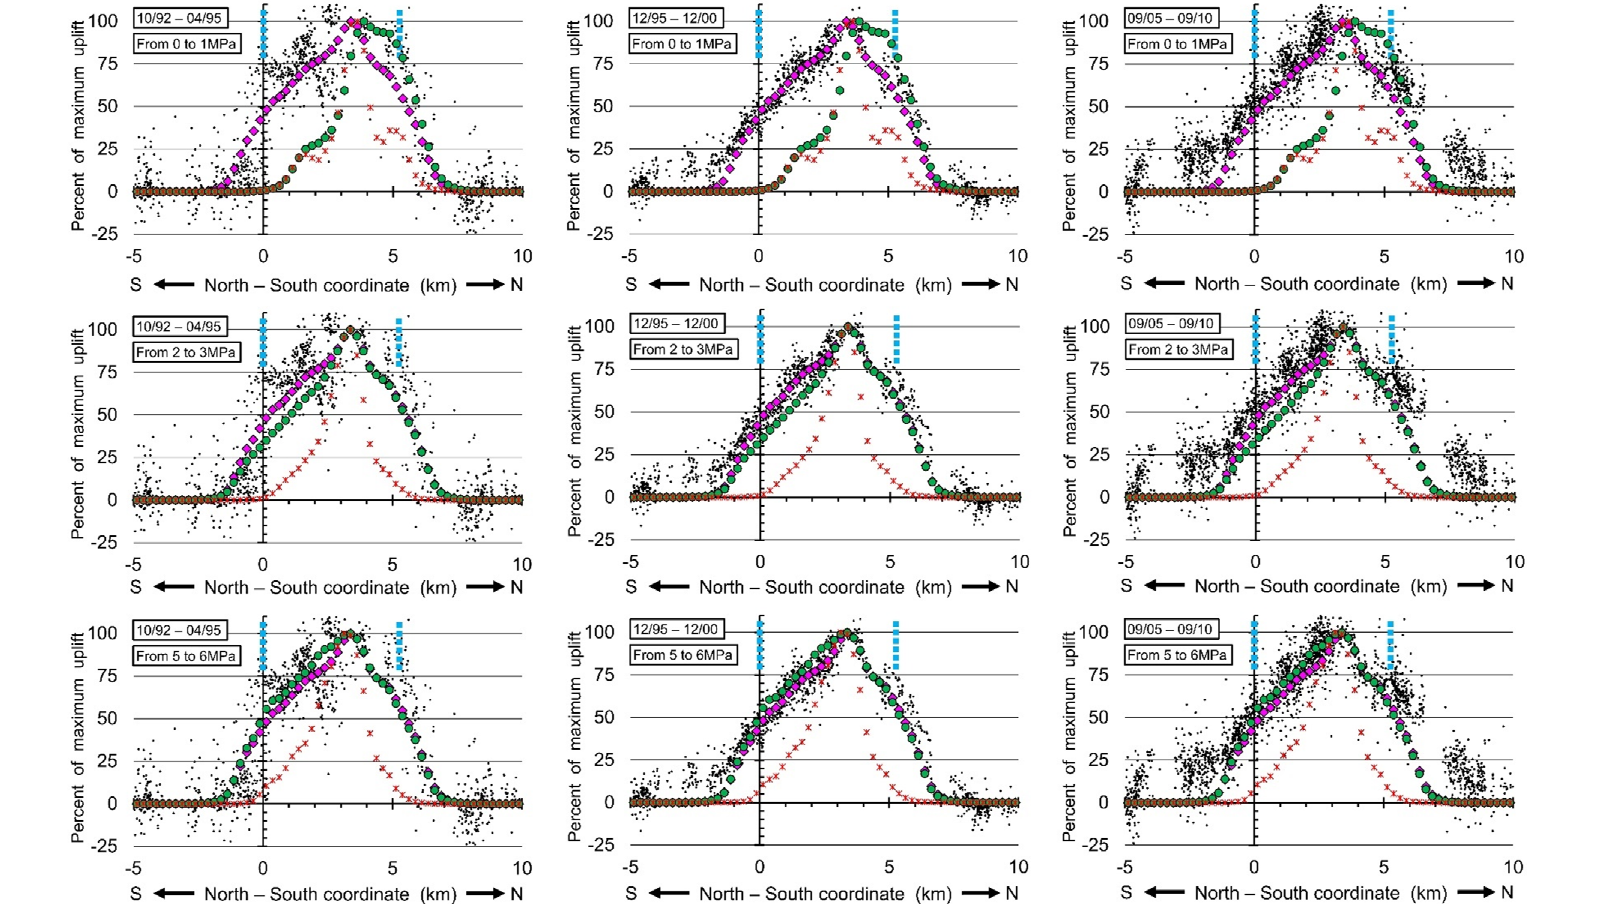
Figure 4. Comparison between InSAR data for three different time periods (black dots), estimations based on framework and property values presented in [17] (purple diamonds) and estimations for open reservoir scenario (green circles for contribution by goaf volume and strata surrounding mining activities, and red crosses for contribution by goaf volumes only). The three time periods are from October 1992 through April 1995 (left column), from December 1995 through December 2000 (middle column) and from September 2005 through September 2010 (right column). Three different increases in water height are presented (the same increase is presented per row; see labels and explanation in text). The limits of the mined area are indicated by blue square dotted lines.